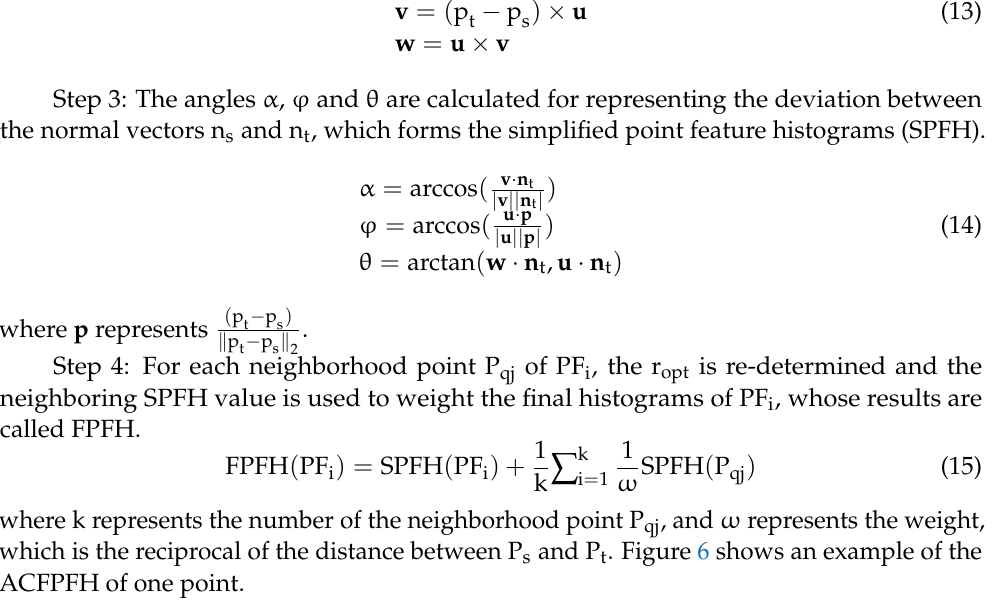
Figure 5. Local coordinate system.